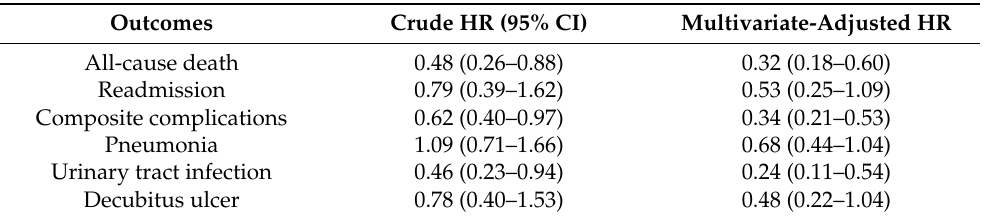
Table 3. Comparison of hazard ratios for outcomes of the acupuncture and control